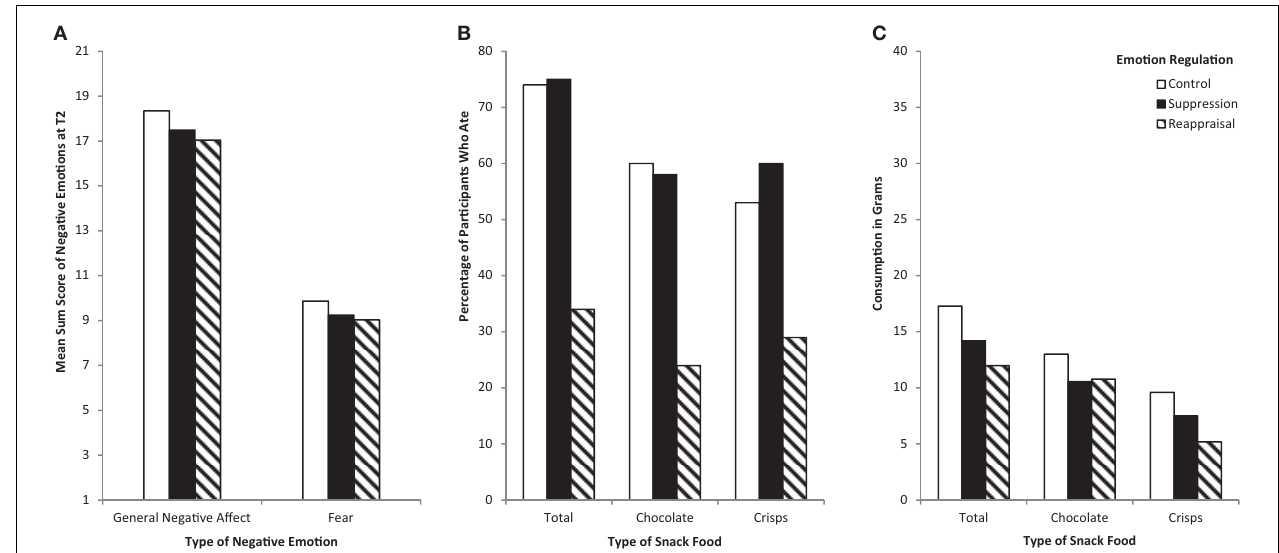
FIGURE 1 | (A) Negative emotions (T2, N =165), (B) percentage of participants who ate ( N =165), (C) amount of food consumed (for participants who ate) in the emotion regulation condition.